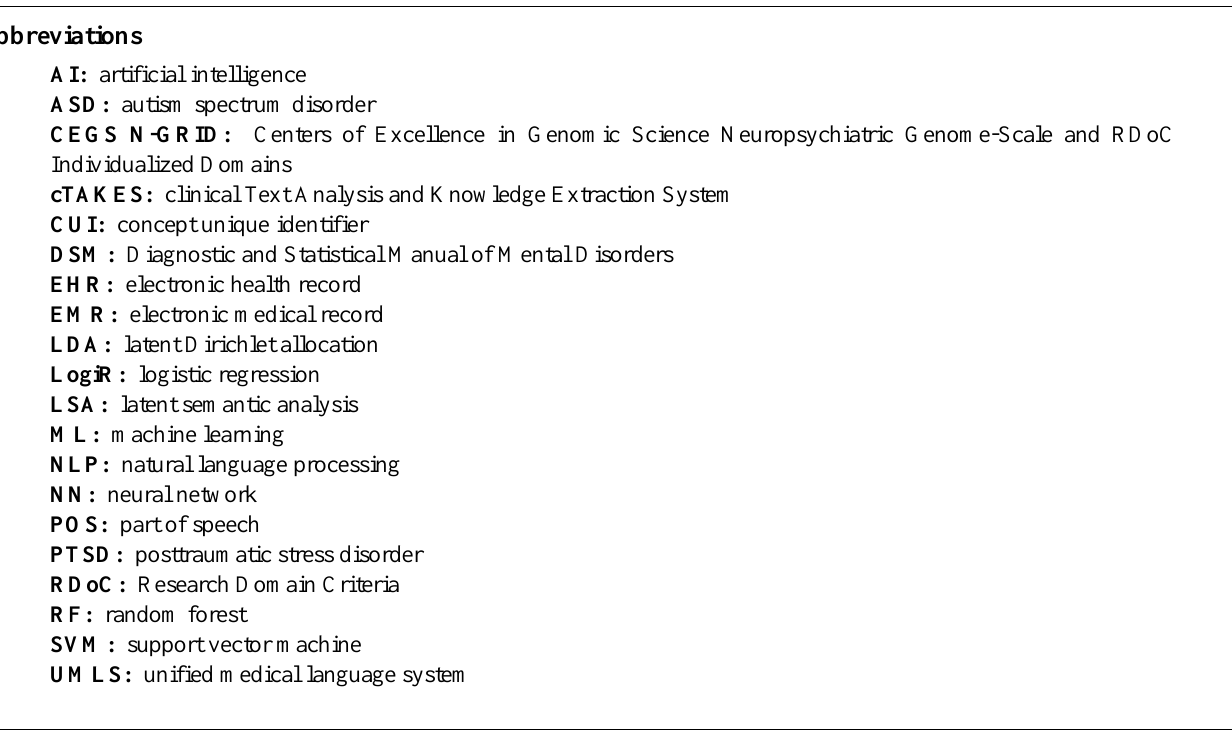
115. Martinez-Martin N. Is It Ethical to Use Prognostic Estimates from Machine Learning to Treat Psychosis? AMA Journal of Ethics 2018 Sep;20(9):e804-811. [doi: 10.1001/amajethics.2018.804] [Medline: 30242810]